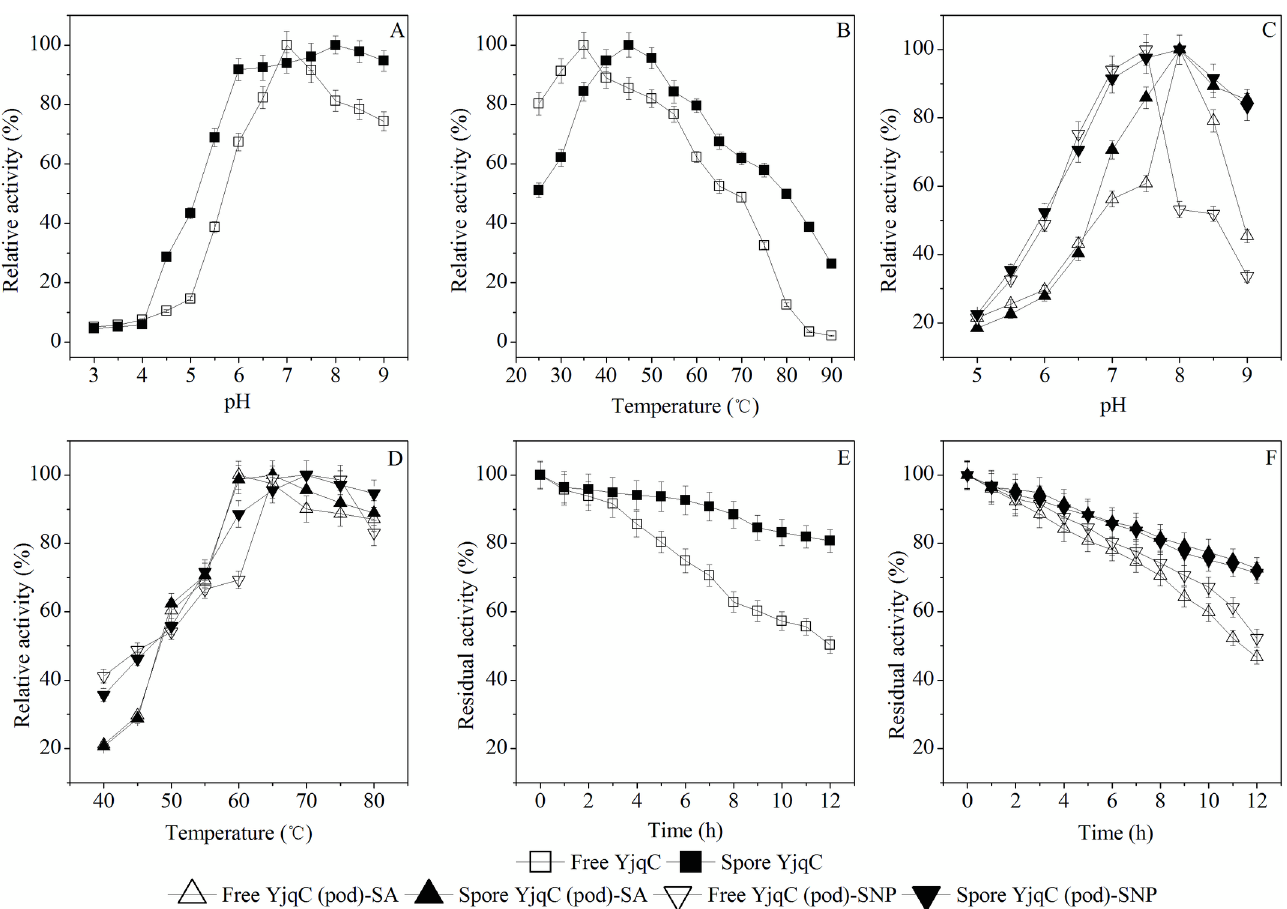
Fig 3. Optimal activity of the free and spore YjqC. Catalase activity under different pH (A) and temperature (B) conditions. Peroxidase activity toward SA and SNP under different pH (C) and temperature (D) conditions. Stability of catalase (E) and peroxidase (F) activity under optimal pH and temperature